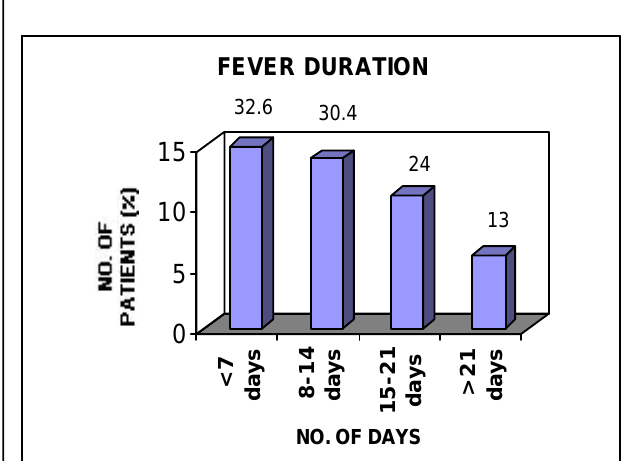
Fig. 4 : Serum creatinine